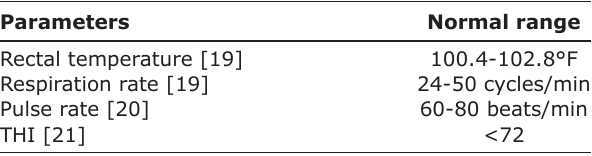
Table-1: Normal range of parameters.